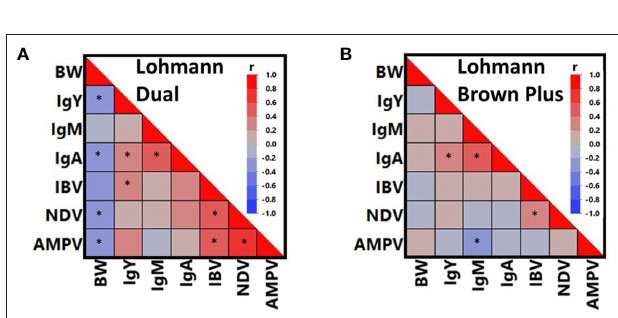
FIGURE 4 | Color maps presenting correlations between body weight (BW), total immunoglobulin isotypes (IgY, IgM, IgA) and vaccine-induced antibody titers against Infectious Bronchitis Virus (IBV), Newcastle Disease Virus (NDV), and Avian Metapneumovirus (AMPV) in Lohmann Dual (A) and Lohmann Brown Plus (B) chicken genotypes. * The sign indicates a significant correlation at p <